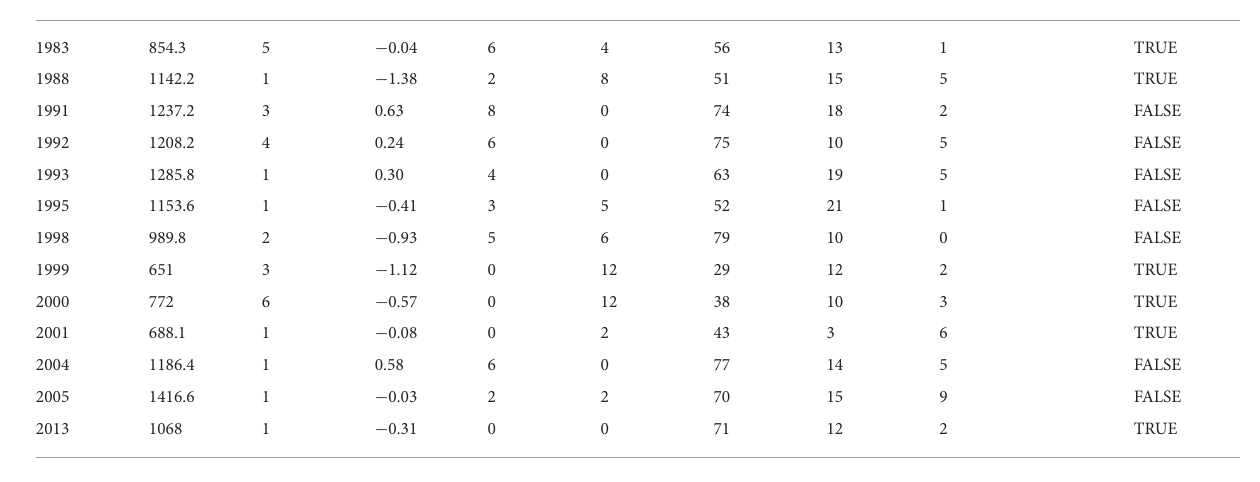
TABLE 2 Analysis of rainfall intensity distribution and climatological indices for high-episodic recharge years in Gundlupet taluk.